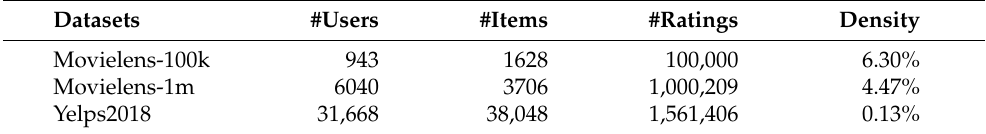
Table 1. Statistical detail of the evaluation